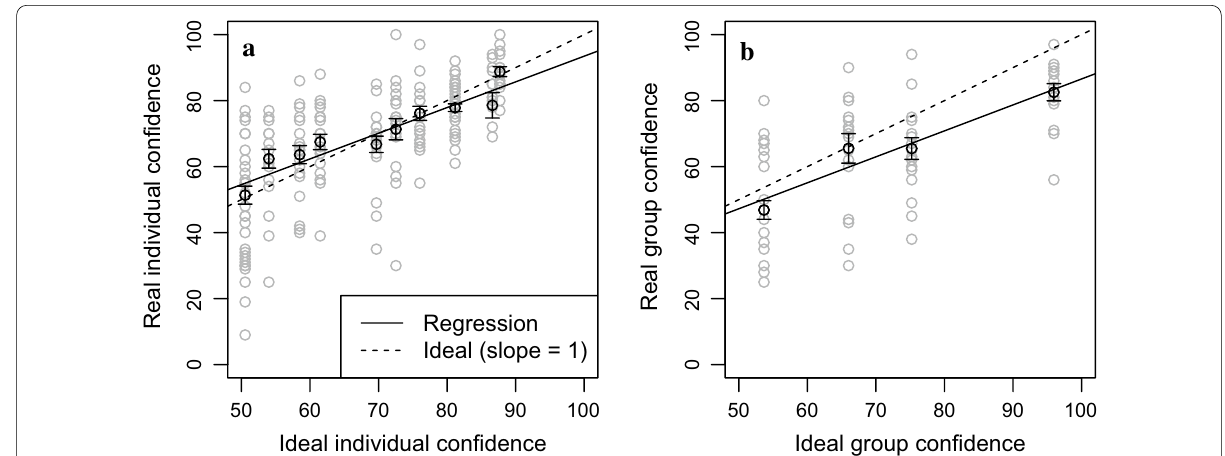
Fig. 3 Comparing ideal versus reported confidences from individuals and groups. Ideal confidence ( x -axis) ranges from 50 to 100% in accordance with Table 1. In contrast, reported confidences ( y -axis) range from 0 to 100% because we flipped confidence ratings in cases where an incorrect decision was given (e.g., a reported confidence of 60% toward the incorrect decision is displayed as a confidence of 40% here). In a , reported confidences from individuals ( y -axis) are compared to the ideal values ( x -axis; cf. c ∗ 1 , c ∗ 2 , and c ∗ 3 from Table 1). Similarly in b , reported confidences from groups ( y -axis) are compared to the ideal values ( x -axis; cf. c ∗ g from Table 1). Black points indicate mean values—averaged across individuals in a and across groups in b —for each ideal value. Grey points indicate single trial responses. Error bars indicate standard errors of the